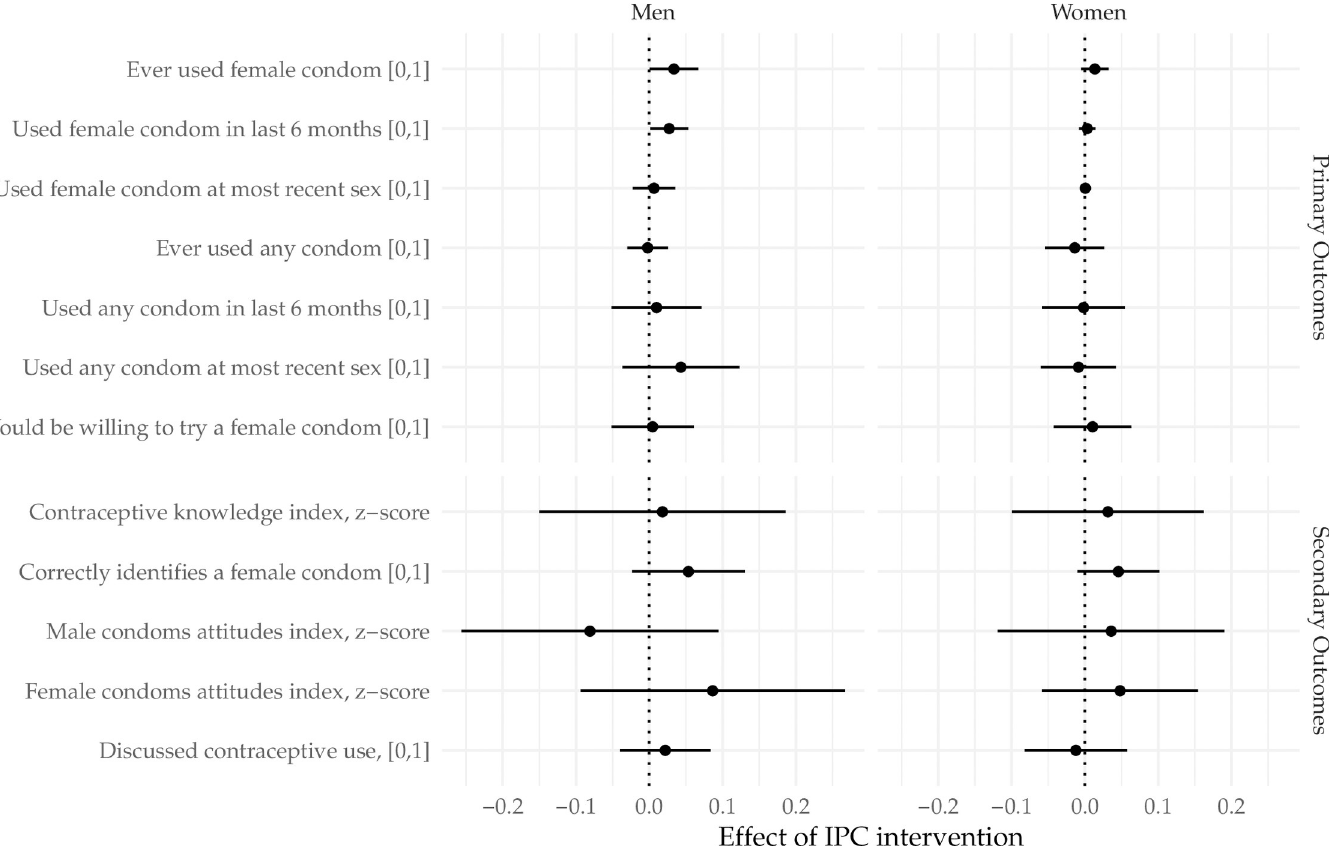
Fig 2. Gender specific effects of the IPC intervention on key primary and secondary